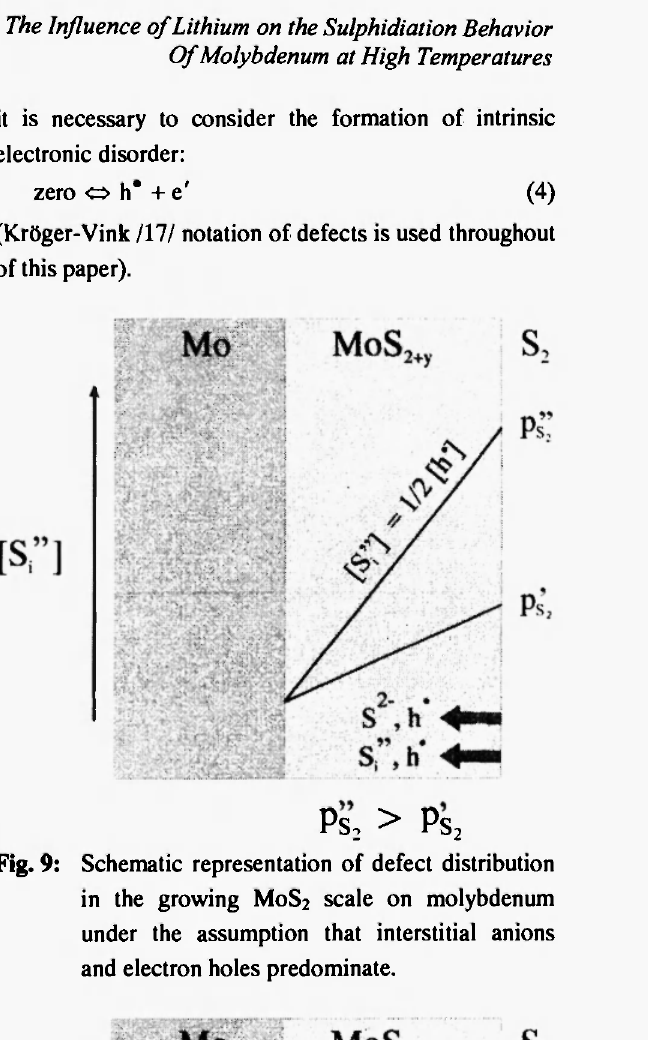
Fig. 9: Schematic representation of defect distribution in the growing M0S2 scale on molybdenum under the assumption that interstitial anions and electron holes predominate.